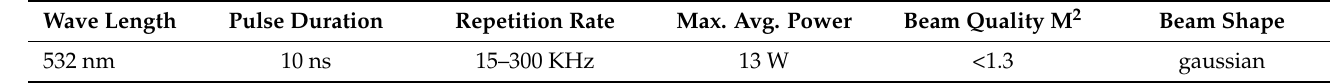
Table 2. Parameters of the used laser system.